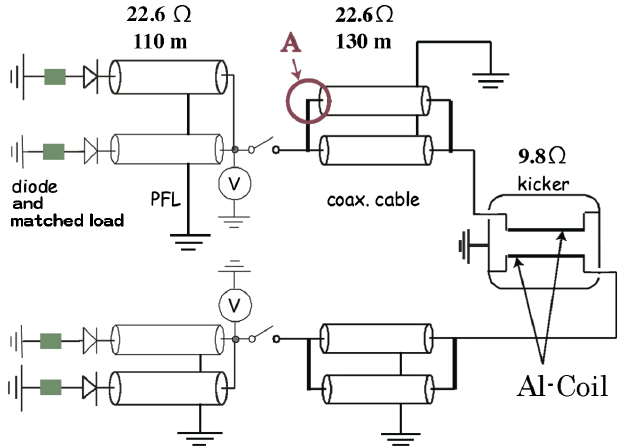
FIG. 1. A schematic overview of the kicker magnet, high- lighting the Al coil and the pulse-forming lines (PFLs), in terms of electric circuit theory [7,8]. The location “ A ” shows the current monitoring point of Fig.